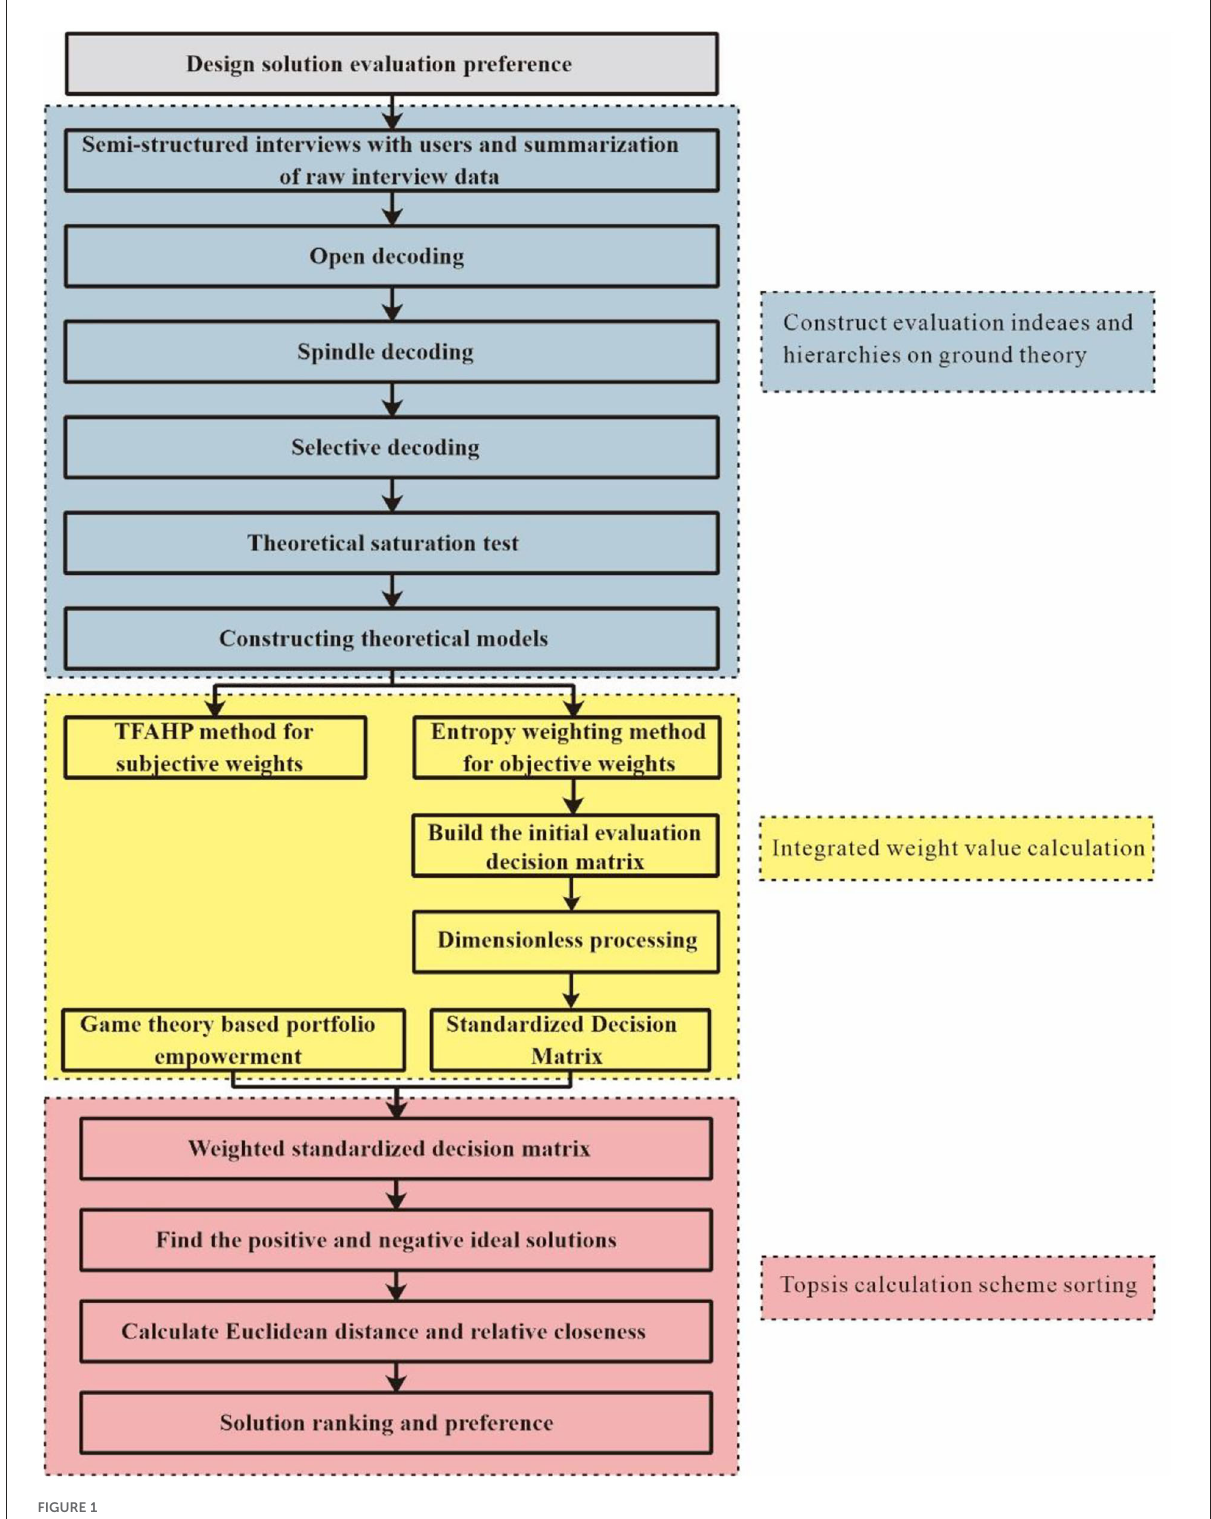
FIGURE1 Comprehensive evaluation decision